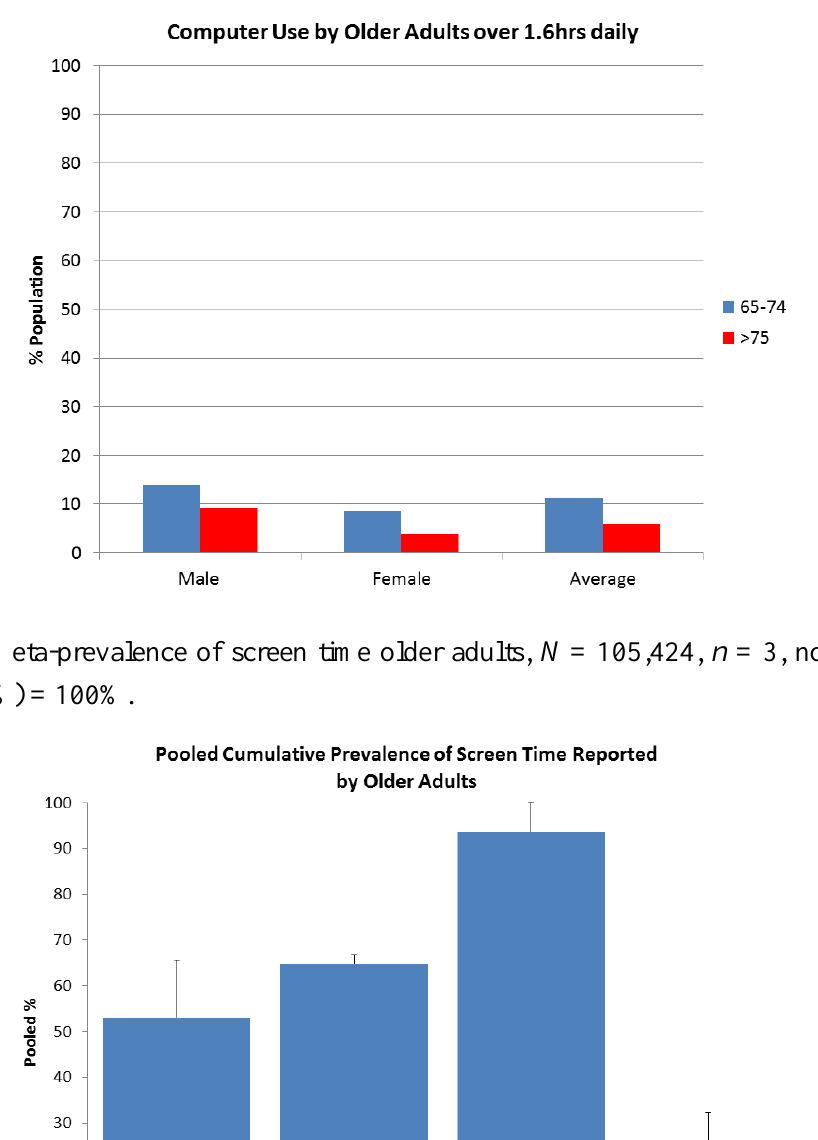
Figure 5. Prevalence of computer use over 1.6 h daily reported by 6,742 older adults.